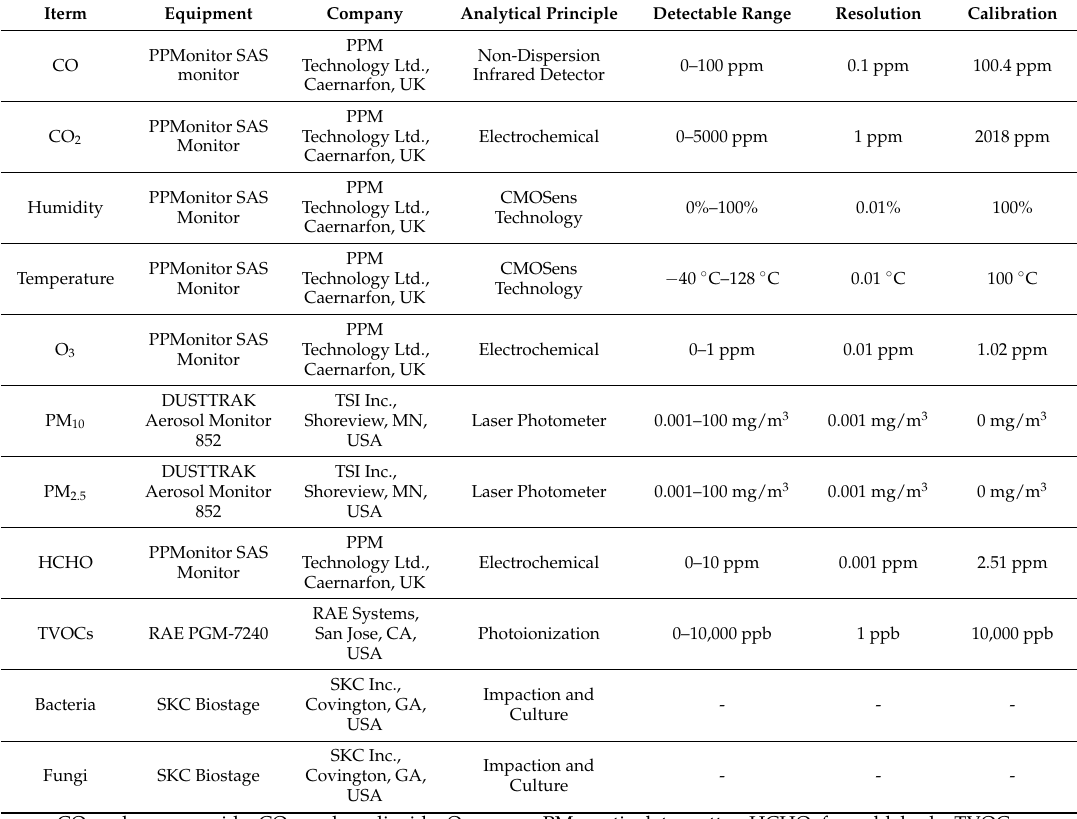
Table 2. Instruments for indoor air quality assessment for the Taipei Rapid Transit System